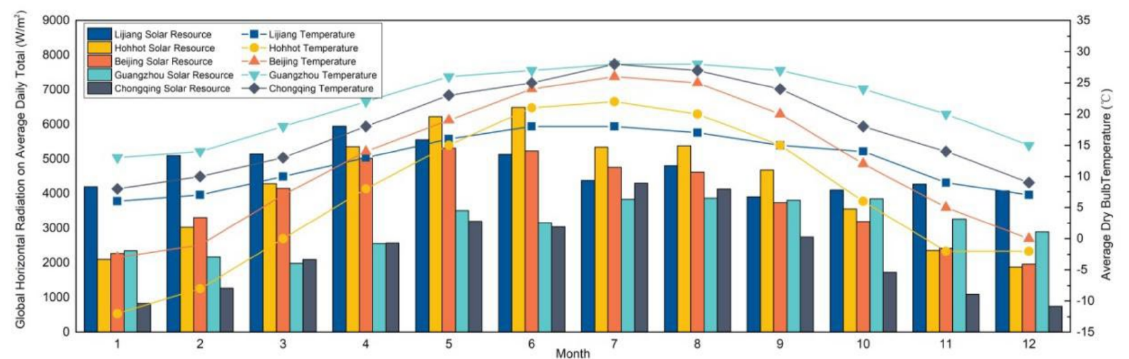
Figure 2. Solar resources and temperatures in the selected cities.